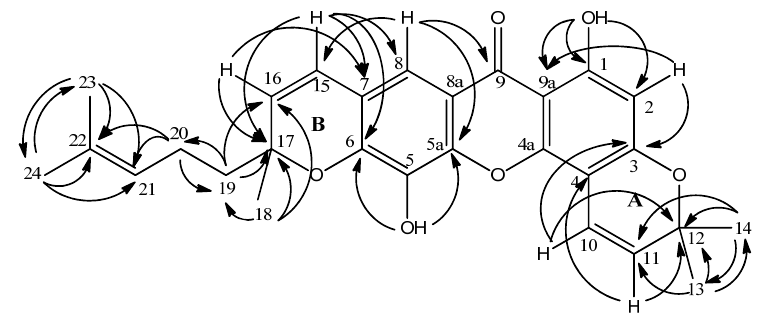
Figure 3. 2 J and 3 J correlations between 1 H and 13 C in HMBC